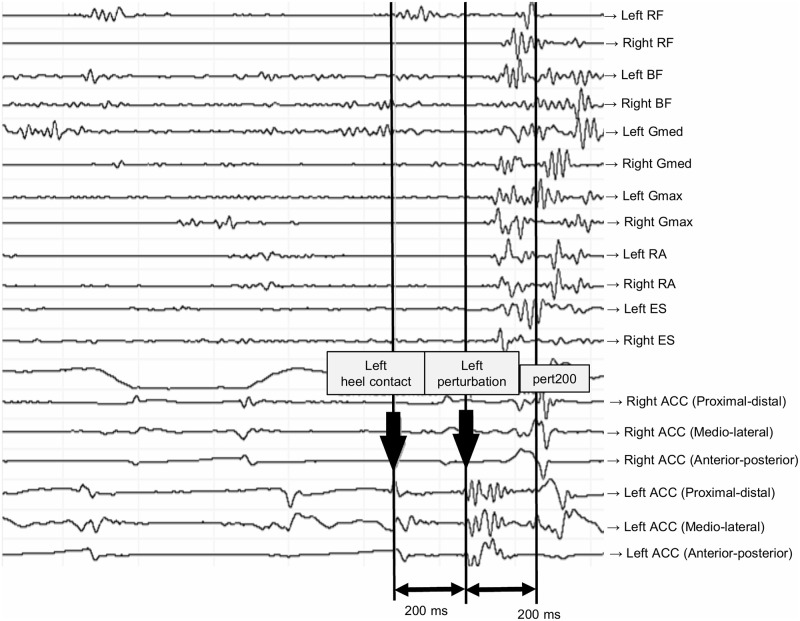
Visualized signals for each recorded muscle and the acceleration sensors in the electromyography analysis software during a left-walking perturbation.Onset of perturbation provoked visible spikes, which assisted the data analyzer in detecting onsets of perturbation. RF: rectus femoris, BF: biceps femoris, Gmed: gluteus medius, Gmax: gluteus maximus, RA: rectus abdominus, ES: erector spinae. ACC: the acceleration sensor. Pert200: 0 to 200 ms after the perturbation in the perturbed walking trail.